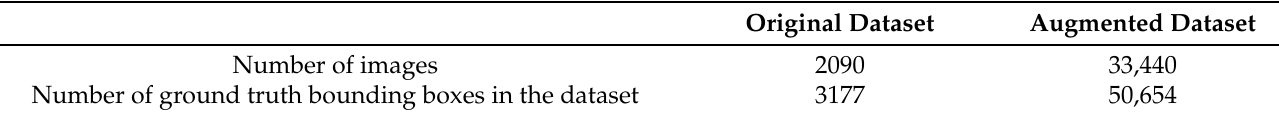
Table 2. Comparison of original and augmented training data.